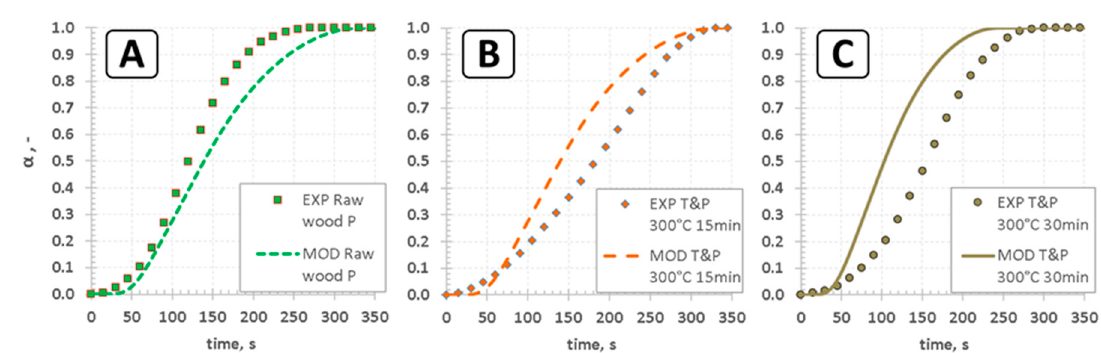
Figure 3. Rate of conversion – comparison of model and experiment for pyrolysis of pellets of raw and torrefied wood at 600 ° C: ( a ) raw wood pellet; ( b ) pellet of fine wood particles torrefied at 300 °C for 5 min; ( c ) pellet of fine wood particles torrefied at 300 °C for 30 min.